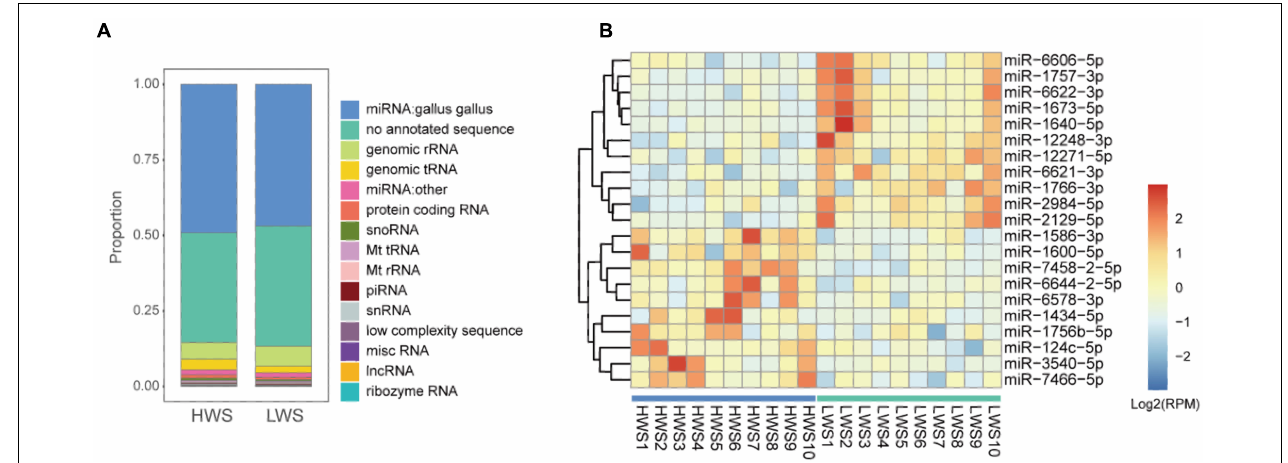
FIGURE 2 | (A) The bar chart of the proportion of total abundance of different types of sncRNAs in HWS and LWS. (B) Heatmap of the expression level of 25 significantly differentially expressed chicken miRNAs (|fold change| > 2 and adjusted p -value < 0.05) in HWS and LWS ( n = 10). The color in the heatmap represents the log 2 of expression values (RPM). The orange color represents a higher expression value than average expression across samples, while the blue color represents the opposite.